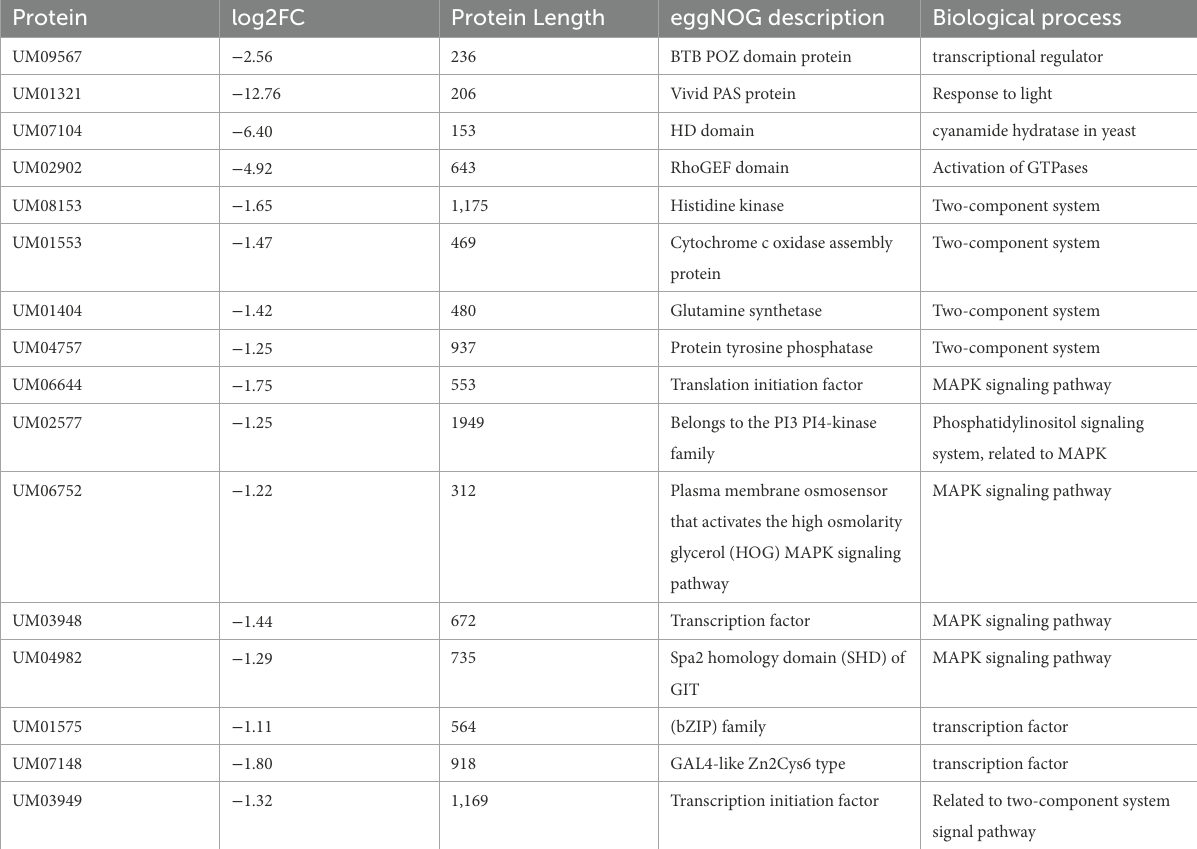
TABLE 1 some genes putatively related to fruiting body formation based on transcriptome analysis in Isaria cicadae.